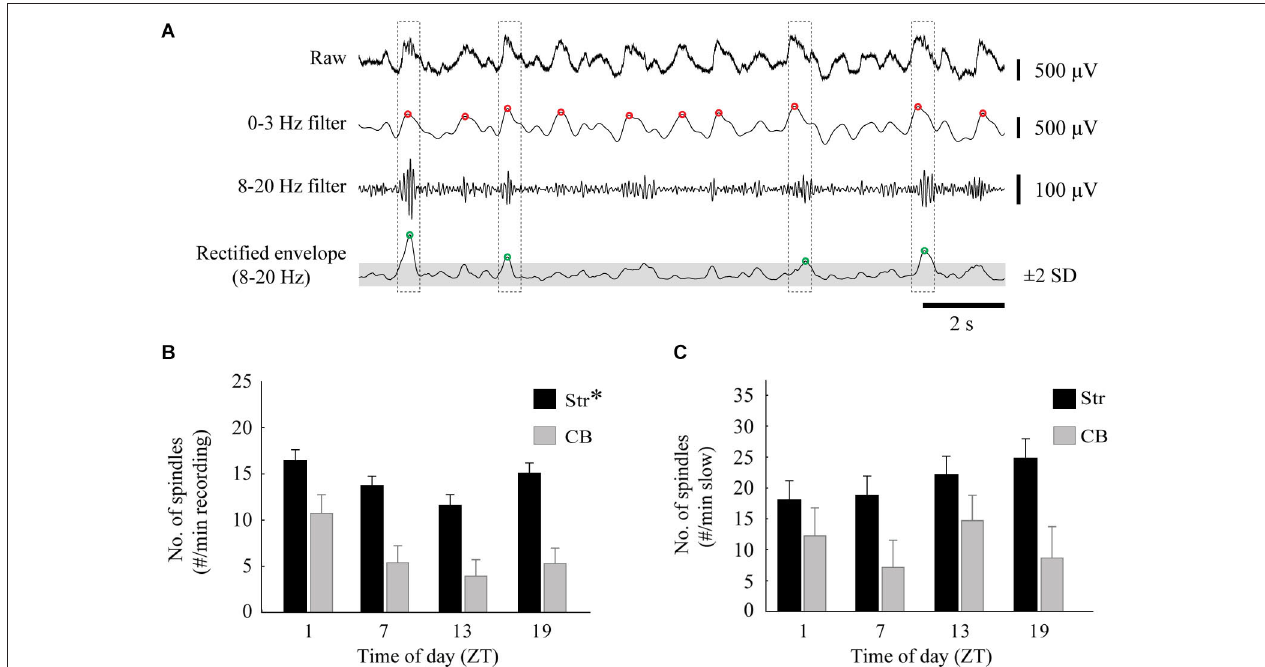
when the peaks of the slow oscillations and 8–20 Hz activity occurred within 0.5 s of each other (dashed boxes). (B) The average number of spindles per minute, calculated from two striatal (one MStr, one LStr) and one cerebellar LFP, for each time of day (asterisk indicates a main effect of ZT, p < 0.05). (C) The average number of spindles, normalized to the percentage of time that the signal spent in slow-wave activity.